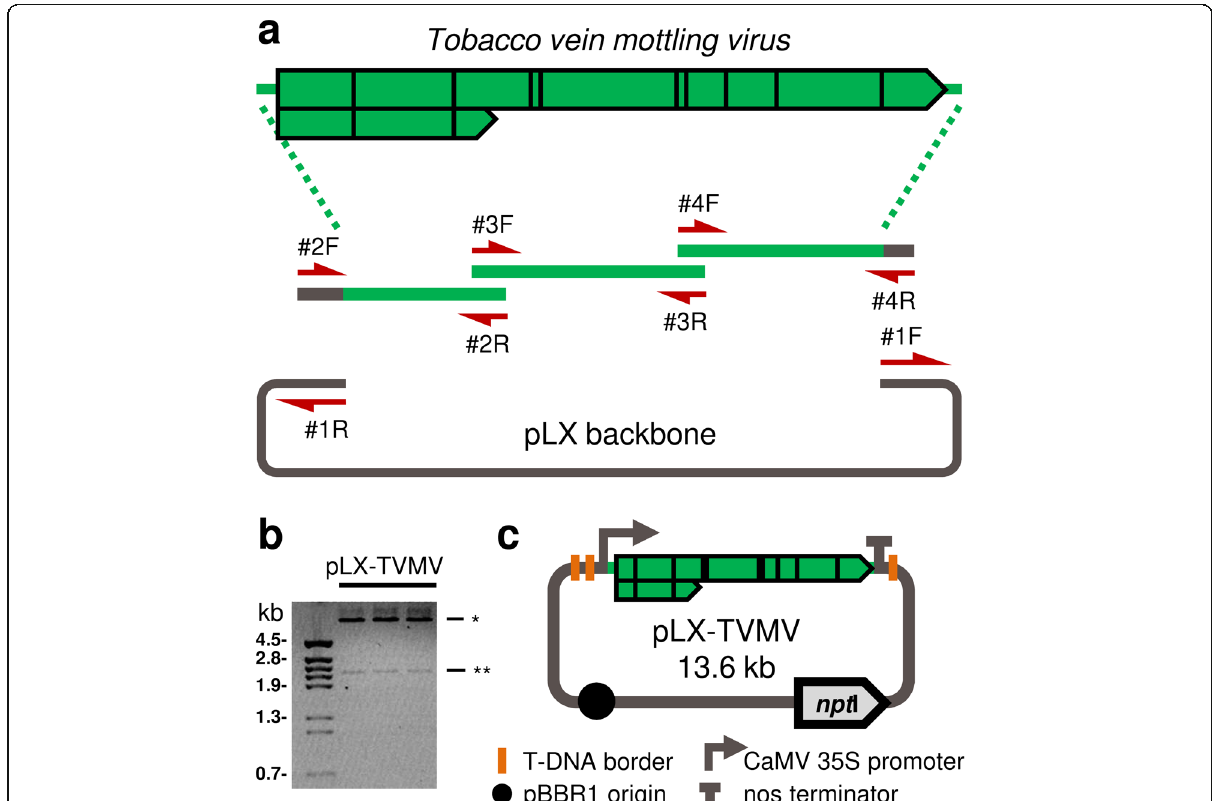
Fig. 1 One-step assembly of a Potyvirus infectious clone by a home-made Gibson assembly enzymatic premix. a Genomic organization of tobacco vein mottling virus (TVMV) and cloning strategy. Three cDNA fragments spanning the TVMV genome were assembled into a linearized T- DNA binary vector (pLX backbone); the PCR primers used are indicated (red arrows). b Digestion profiles are shown of purified plasmids from selected Escherichia coli colonies. Left, DNA size marker; right, the Xba I-digestion pattern computed for pLX-TVMV is shown (**, a TVMV-specific fragment). c Diagram of pLX-TVMV, a binary vector that includes a cDNA copy of the TVMV genome and regulatory sequences for its plant delivery and expression. Vector components are indicated (bottom); npt I, kanamycin resistance